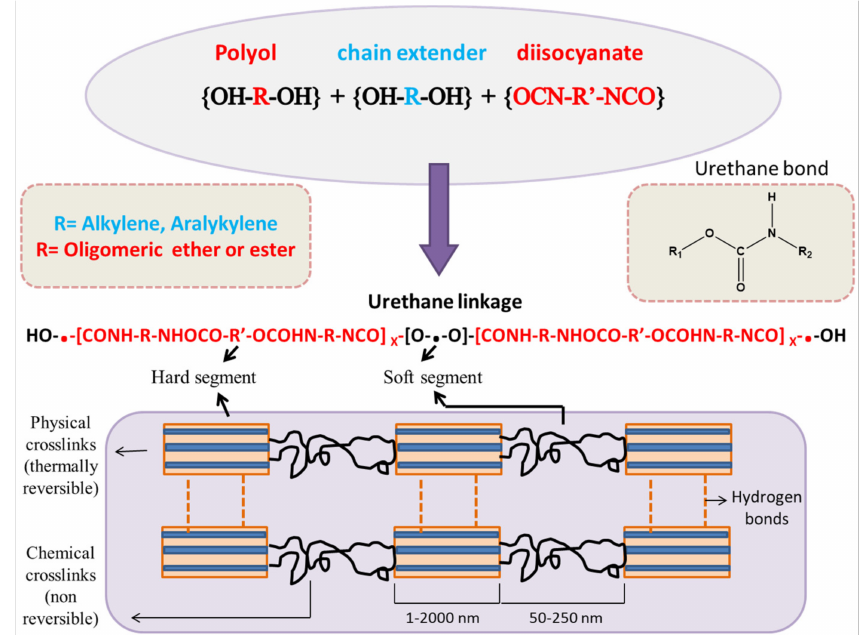
Figure 1. Structural analysis of thermoplastic polyurethane